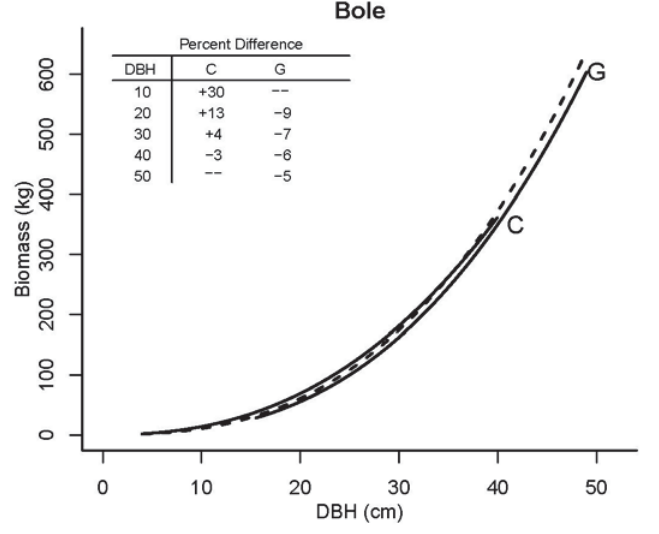
Figure 7. Estimated bole biomass over diameter, at BMEF (dashed line) compared to two published estimates (solid lines C, G) from [13] and [12]; percent differences are tabulated by